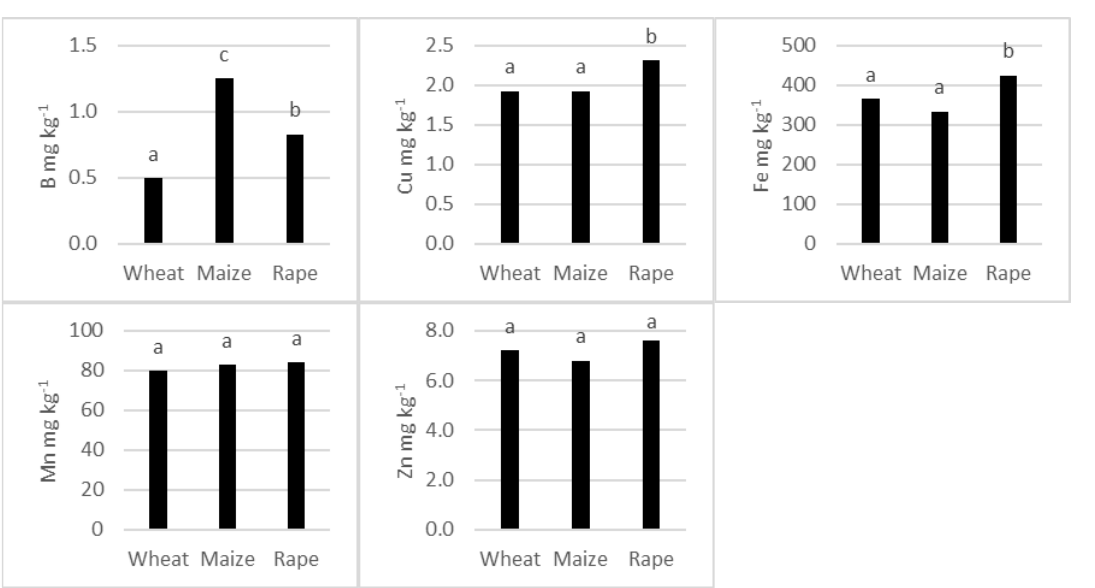
Figure 2. Concentration of micronutrients in the soil determined with the Mehlich 3 extractant — average of all collected samples. Bars marked with the same letters indicate no significant difference according to Tukey’s test ( p < 0.05).